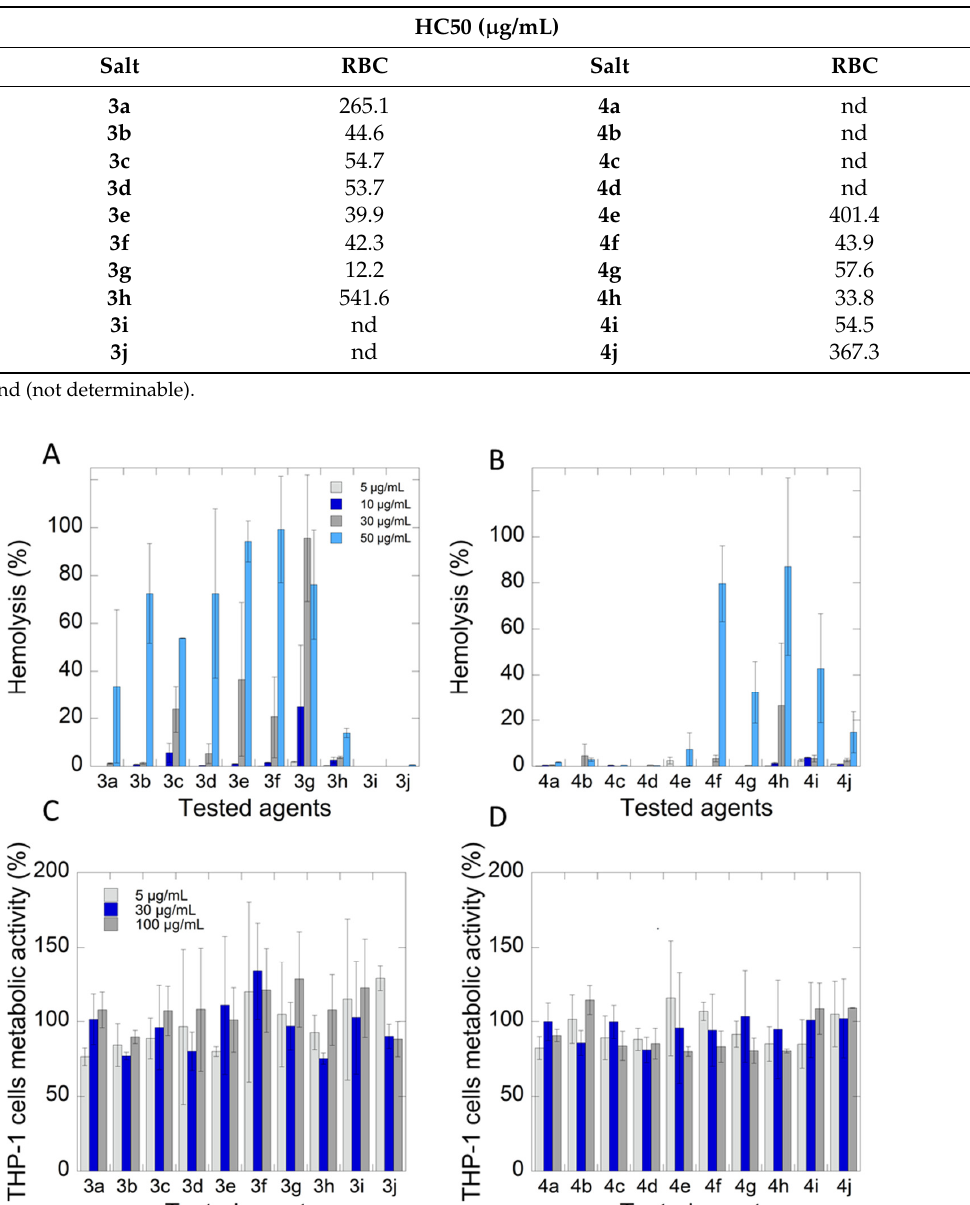
Table 5. Hemolytic concentration of 50 ( HC50) values of imidazolium salts.